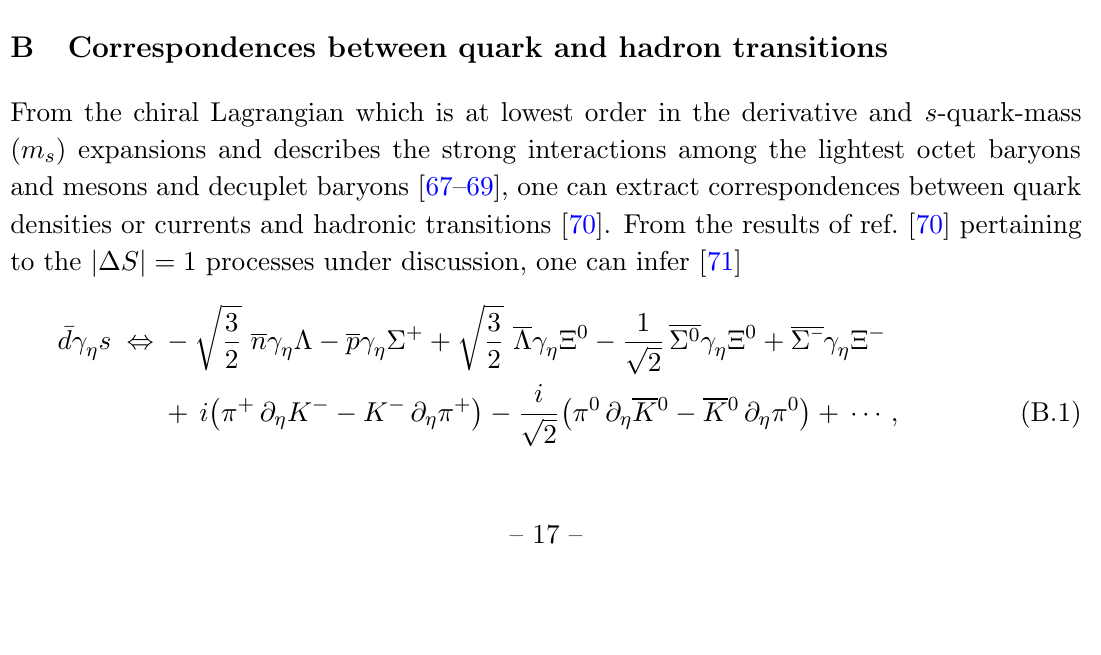
, K + π + ν ¯ ν , and µ − e − conversion L → µ ± e ∓ → → (cid:30) (cid:31) Ξ Ω < 10 − 12 , under the general assumption − → − µ ± e ∓ B = c µe . The specific choices for the nonzero ones are described k k